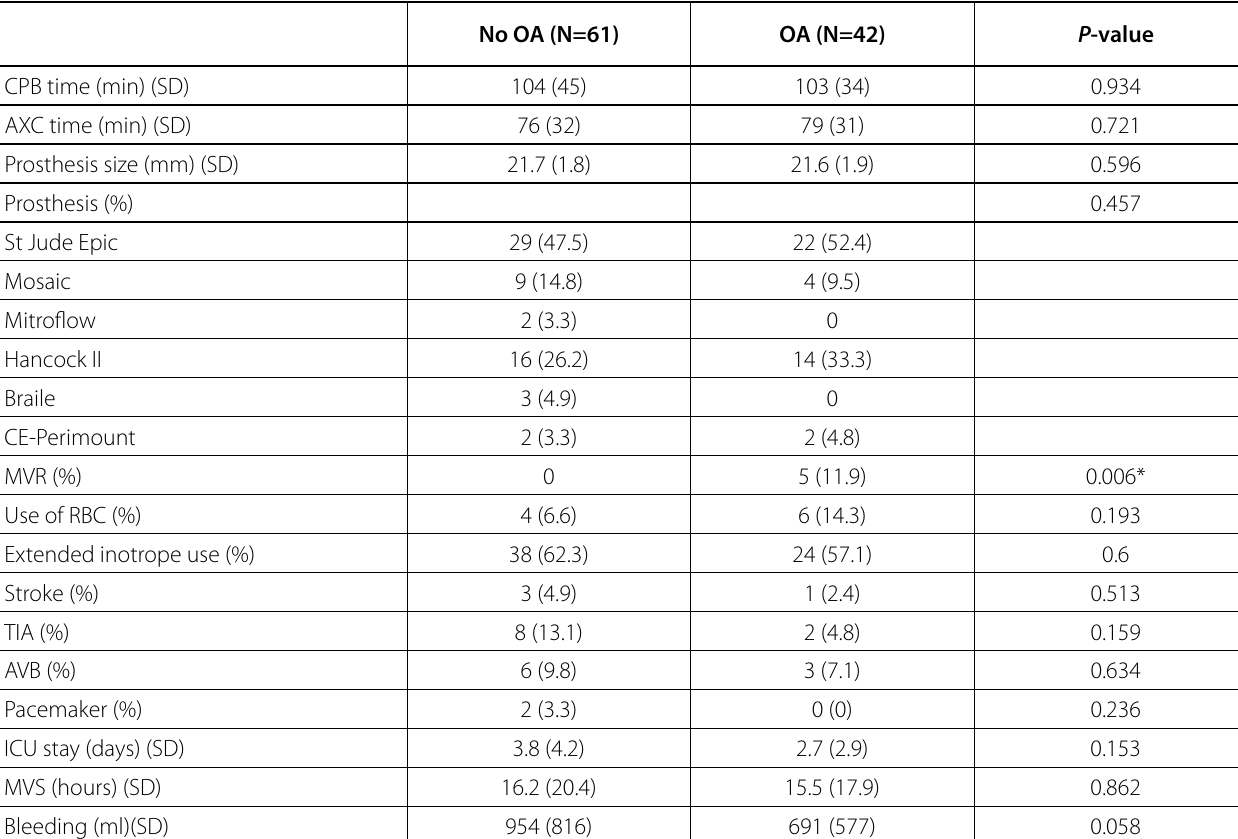
Table 2 . Operative and postoperative outcomes.